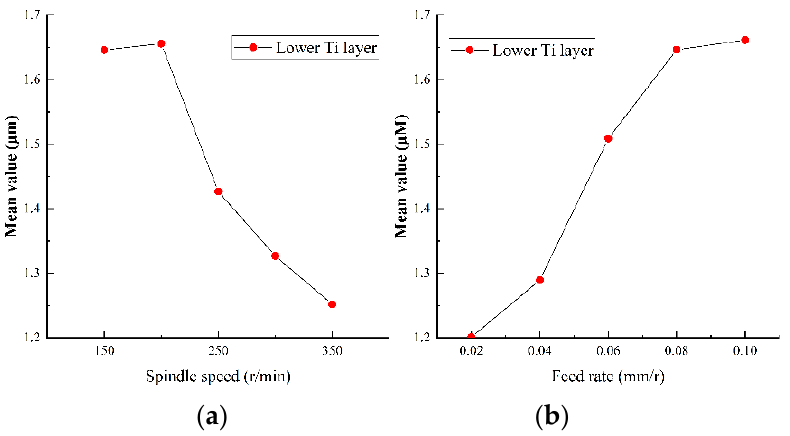
Figure 15. Main effect plots of surface roughness of hole wall for drilling CFRP in ( a ) spindle speed and ( b ) feed rate.